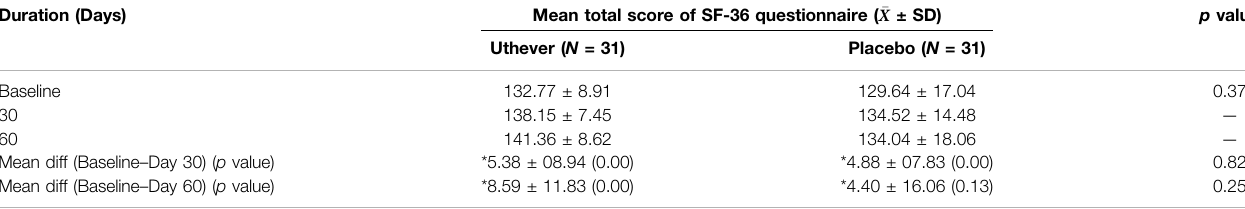
TABLE 4 | Comparison of changes in mean total score of SF-36 questionnaire between the groups.